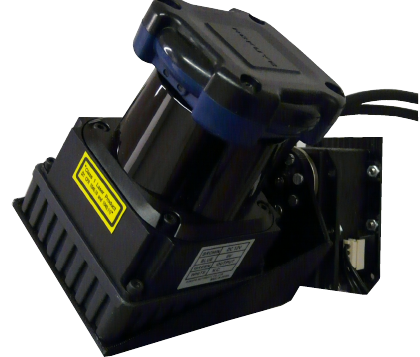
Figure 1. An exemplary setup of an actuated laser scanner. We will use data from this system for our experiments. The laser scanner is a Hokuyo UTM-30LX scanning laser rangefinder that is rotated by a Dynamixel MX-64R robot